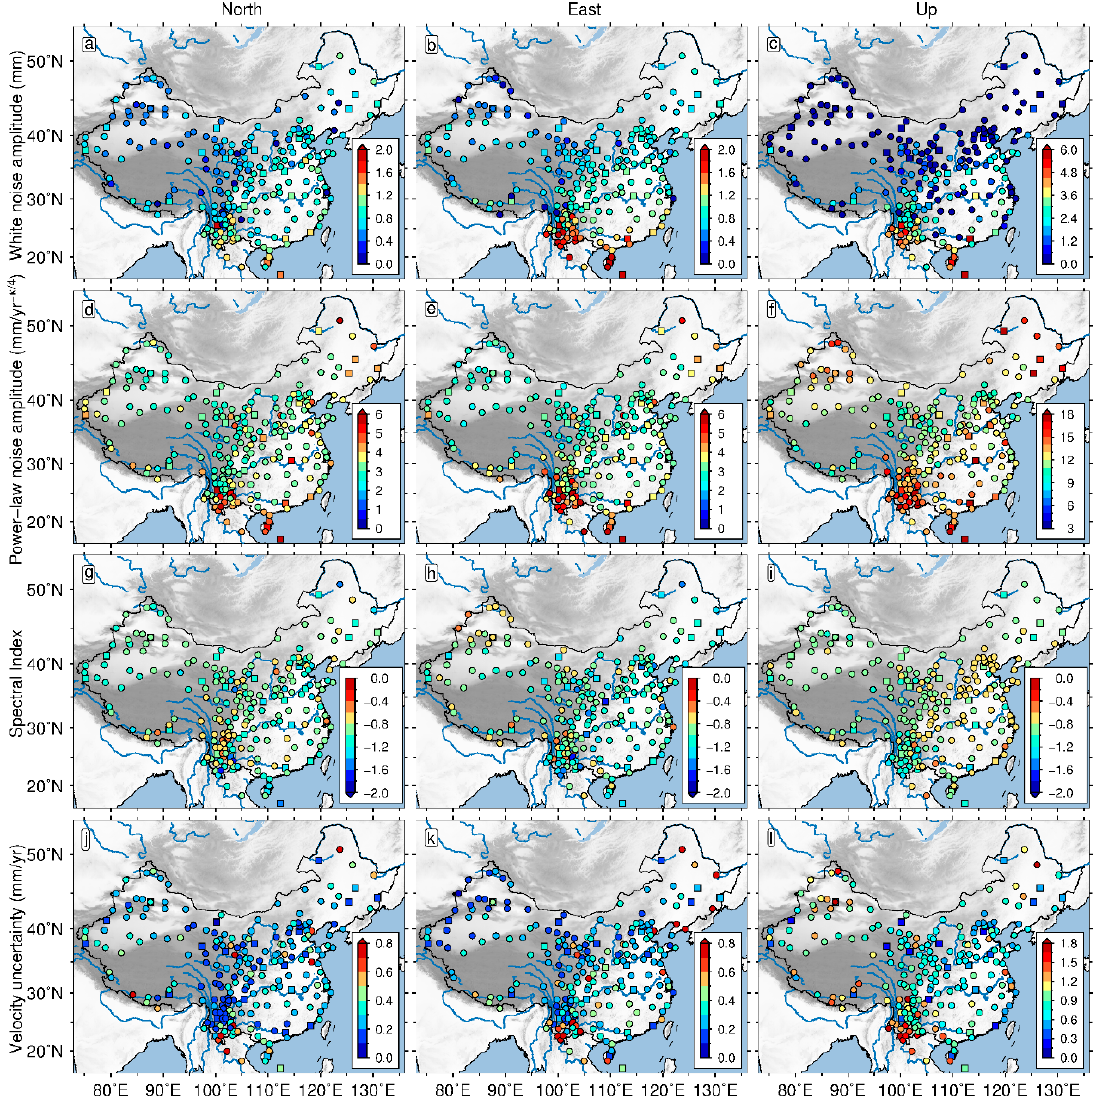
Figure 11. The WN amplitudes for the NEU components ( a – c ); PLN amplitudes for the NEU components ( d – f ); spectral indices for the NEU components ( g – i ) and velocity uncertainties for the NEU components ( j – l ) of the unfiltered time series estimated with the PLN + WN model.